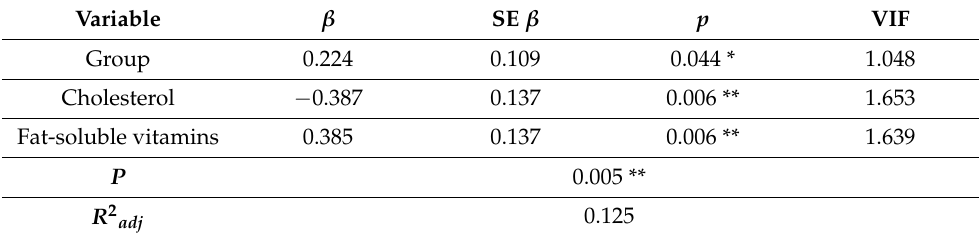
Table 4. Multiple regression analysis of the change in composite memory score and the intake of major nutrients. Variable β SE β p VIF